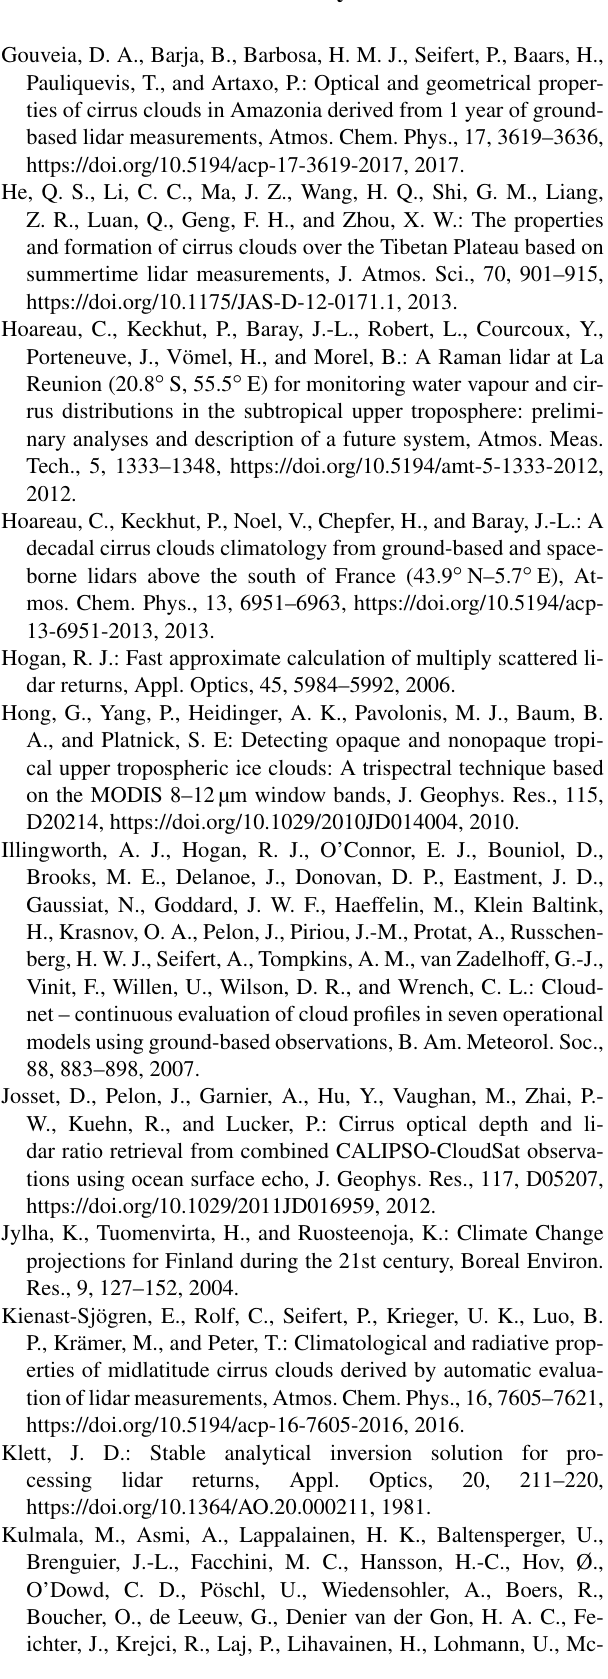
Figgans, G., Mentel, T., Pilinis, C., Riipinen, I., Schulz,